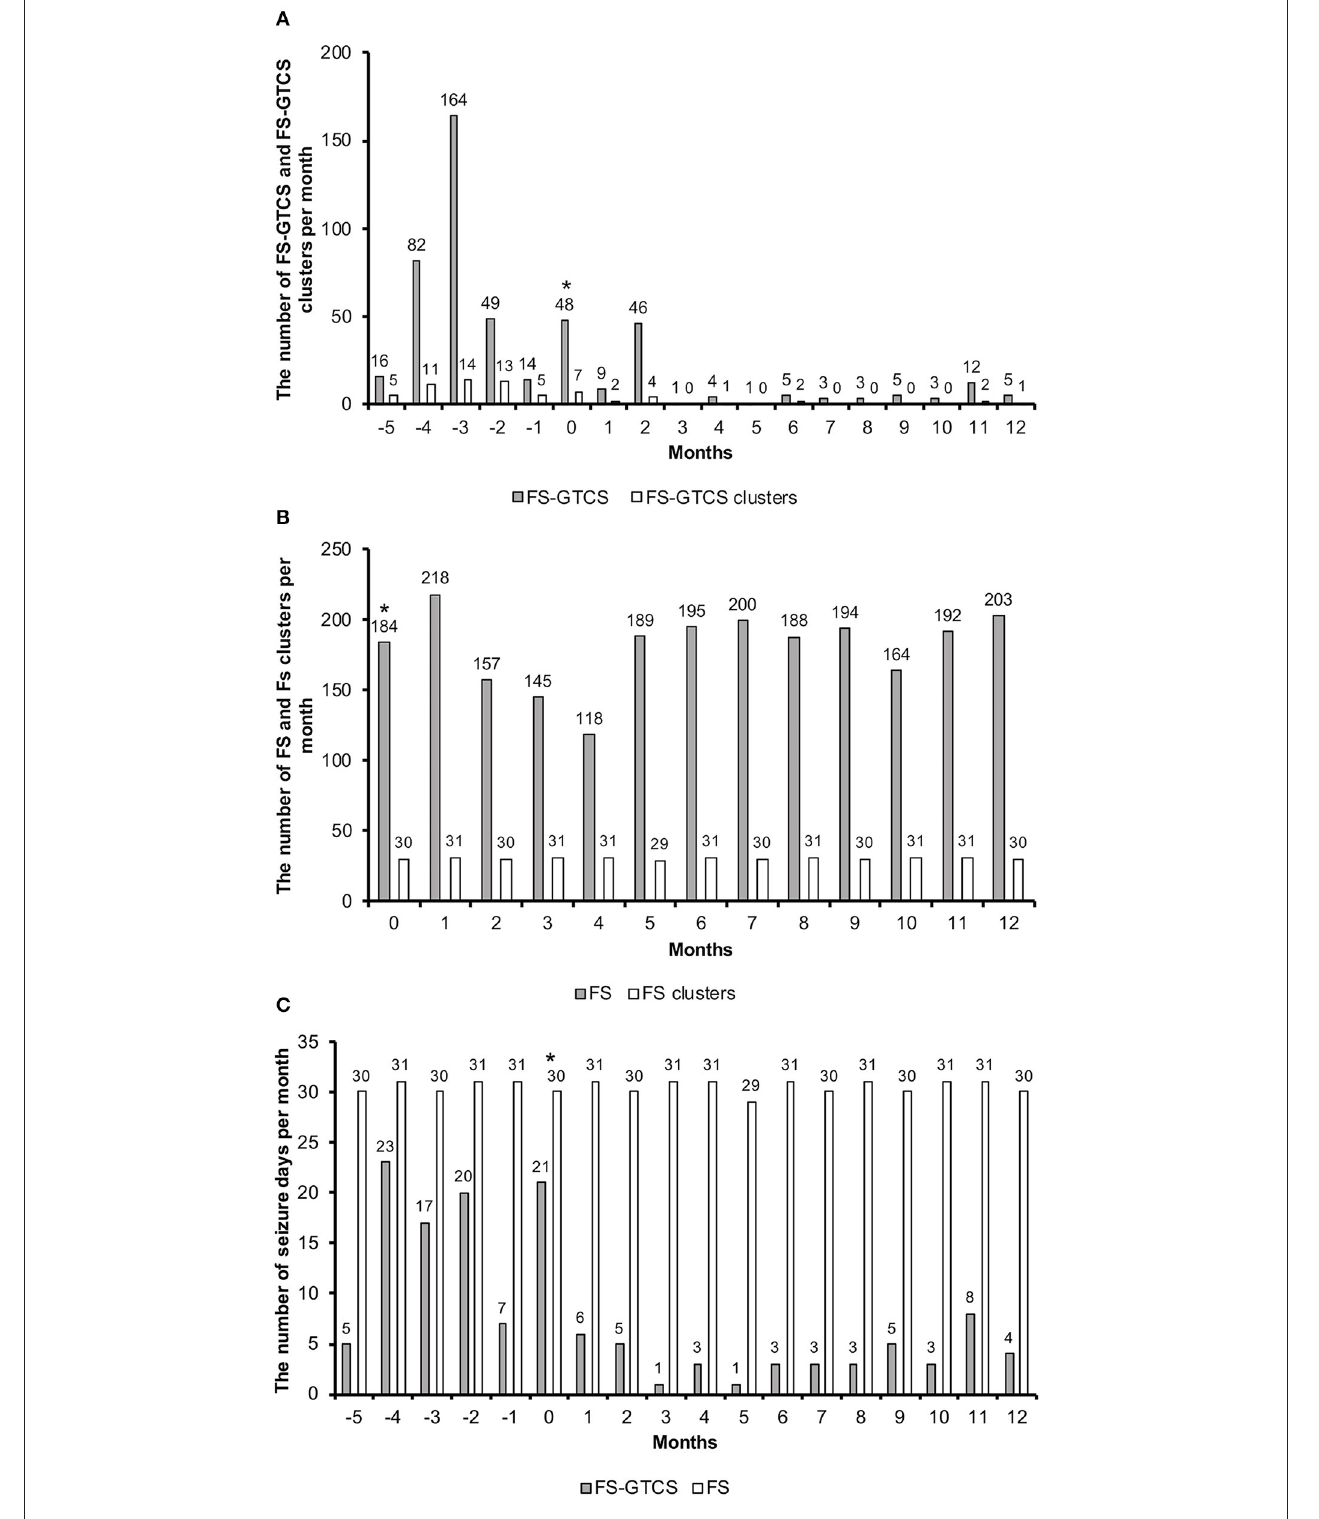
FIGURE 3 | The number of FS-GTCS and FS-GTCS clusters per month (A) . The number of FS and FS clusters per month (B) . The number of seizure days (FS-GTCS and FS) per month (C) . The asterisk indicates that VNS therapy was initiated in this month. Months − 5 to 0 indicate the retrospective period; months 1 to 12 indicate the follow-up period. FS-GTCS, focal seizures evolving into generalized tonic–clonic seizures; VNS, vagus nerve stimulation.